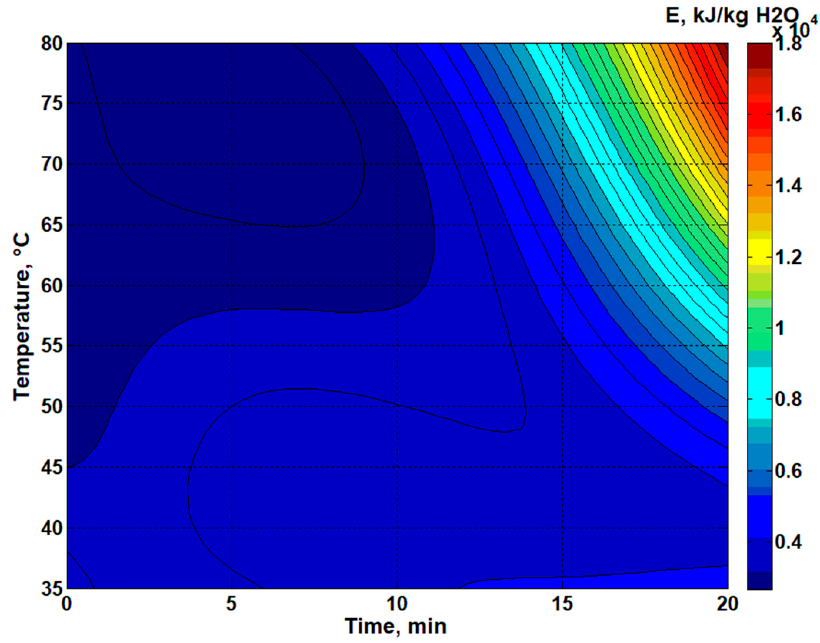
Figure 13. Drying kinetics in the torbed installation for Romanian lignite.